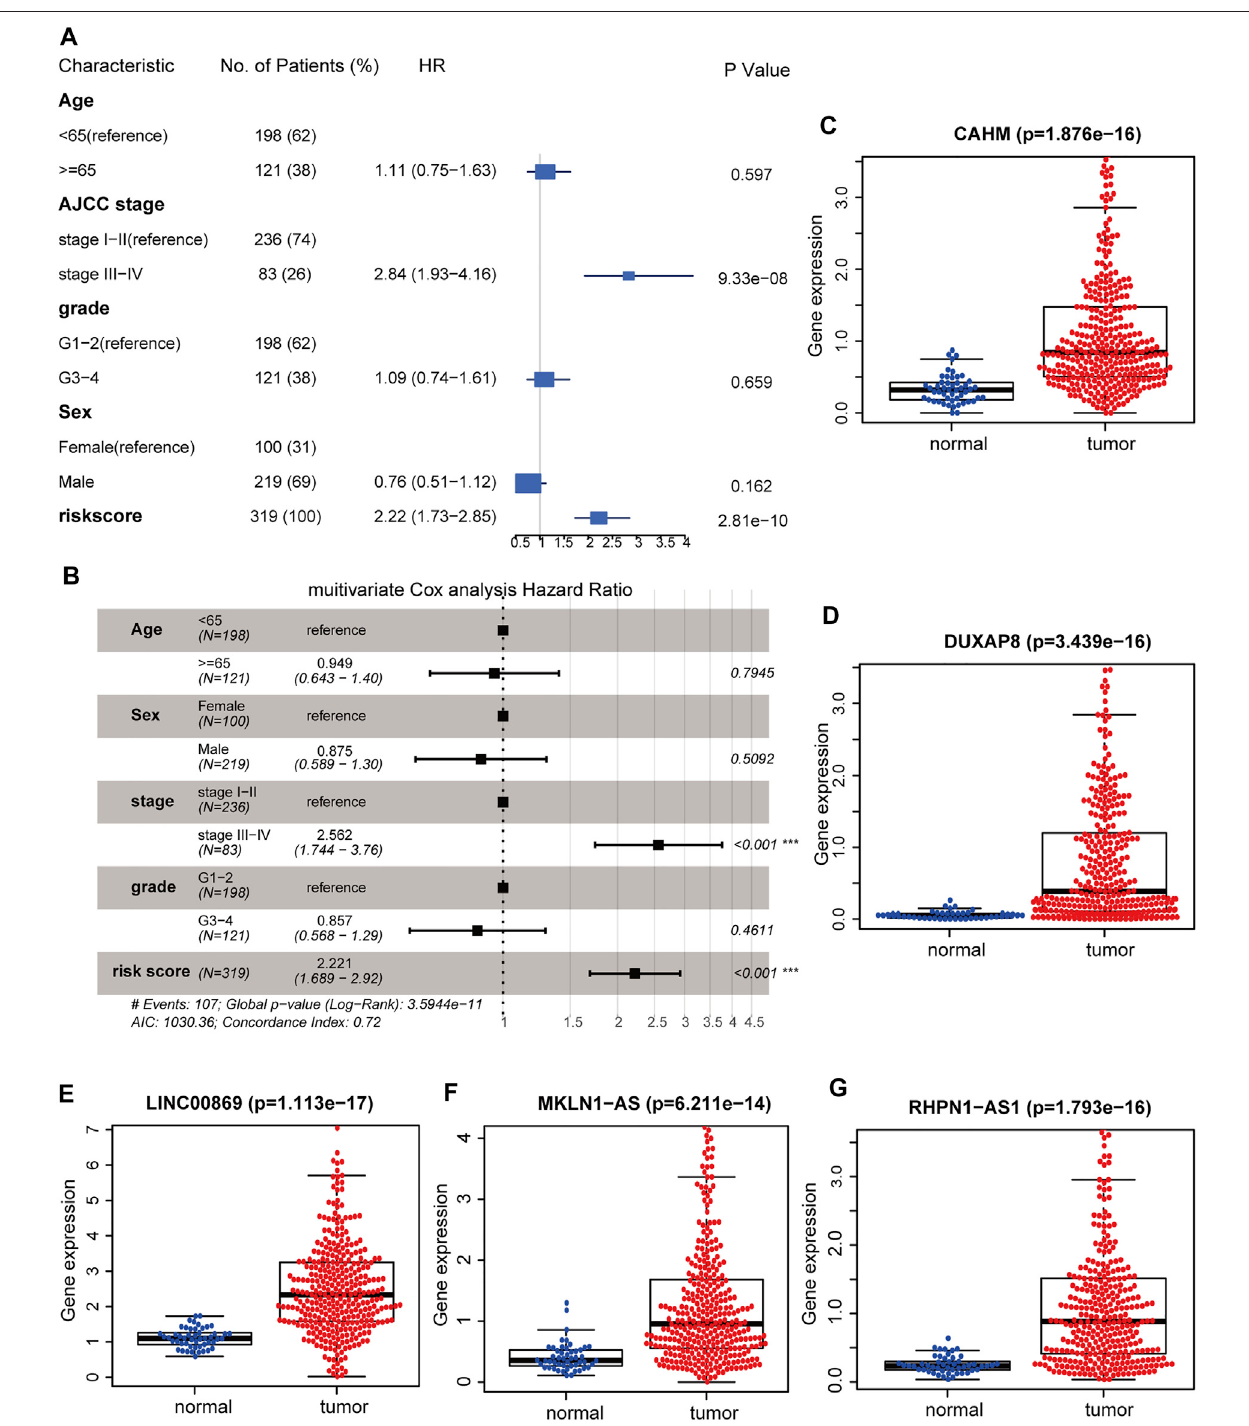
FIGURE 6 | Identifying the hypoxia-related lncRNA signature as an independent prognostic factor. Forest plot of the corresponding p-values of the univariate Cox regression analysis (A) and multivariate Cox regression analysis (B) . Comparisons of the expression levels of CAHM (C) , DUXAP8 (D) , LINC00869 (E) , MKLN1-AS (F) , and RHPN1-AS1 (G) between HCC tumor and adjacent normal tissues in TCGA-LIHC cohort. TCGA: The Cancer Genome Atlas. LIHC: liver hepatocellular carcinoma. ***, p < 0.001; **, p < 0.01; *, p < 0.05.